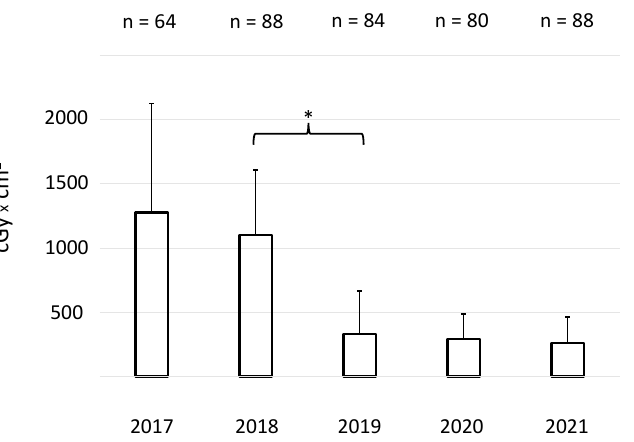
Figure 2. Mean fluoroscopy time (minutes) ± SD of the procedures of each year over a period of five consecutive years. * indicates p < 0.05.